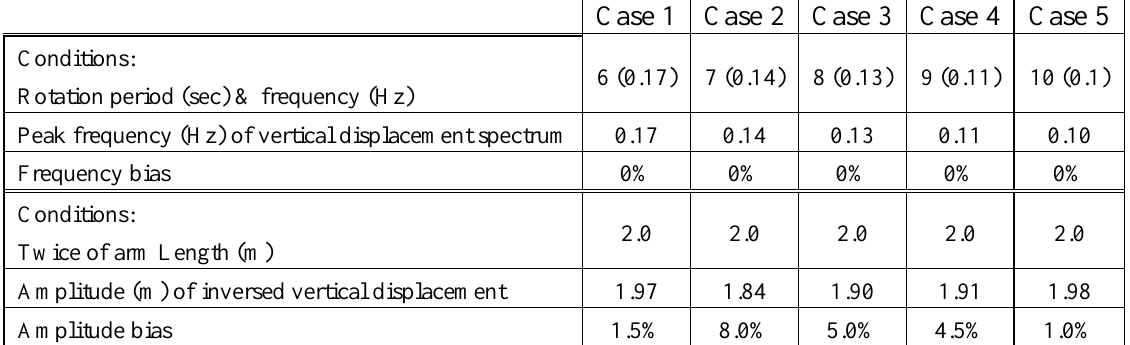
Table 1. Results of inversed vertical displacement